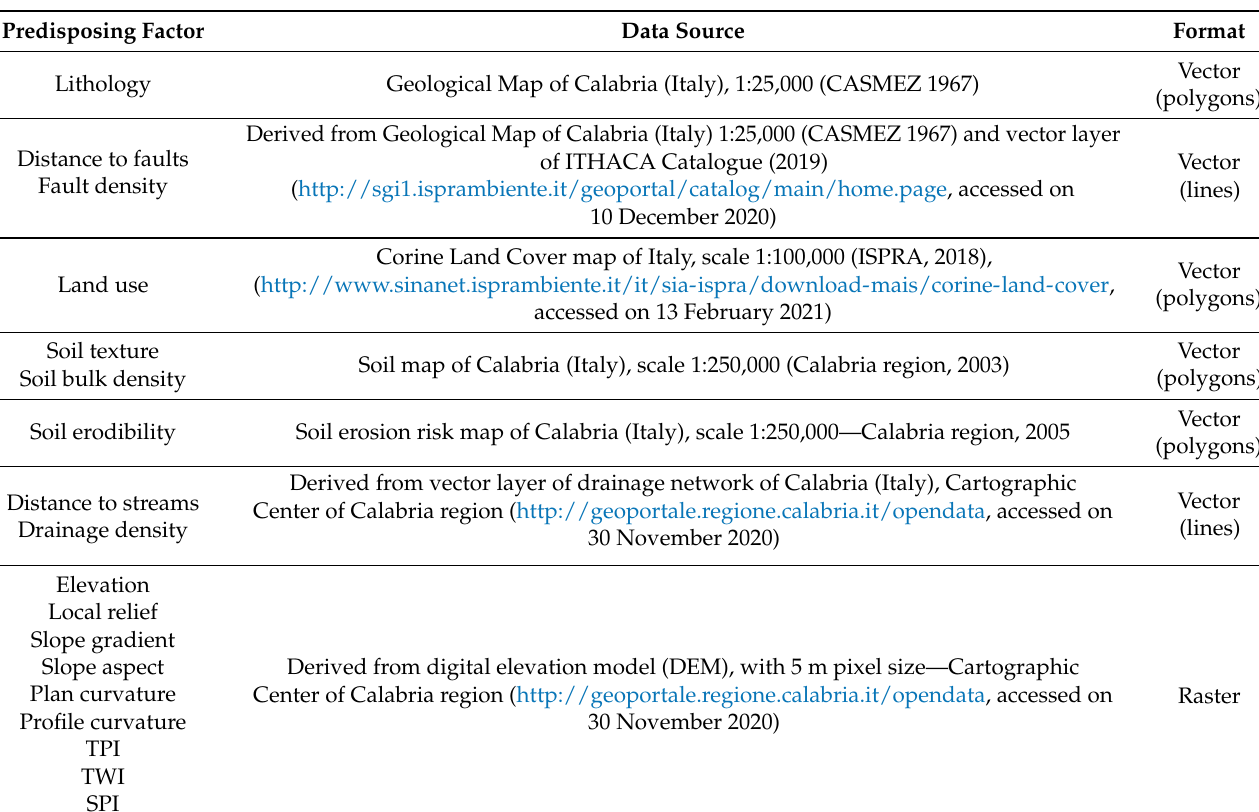
Table 1. Data layers of the spatial database for the predisposing